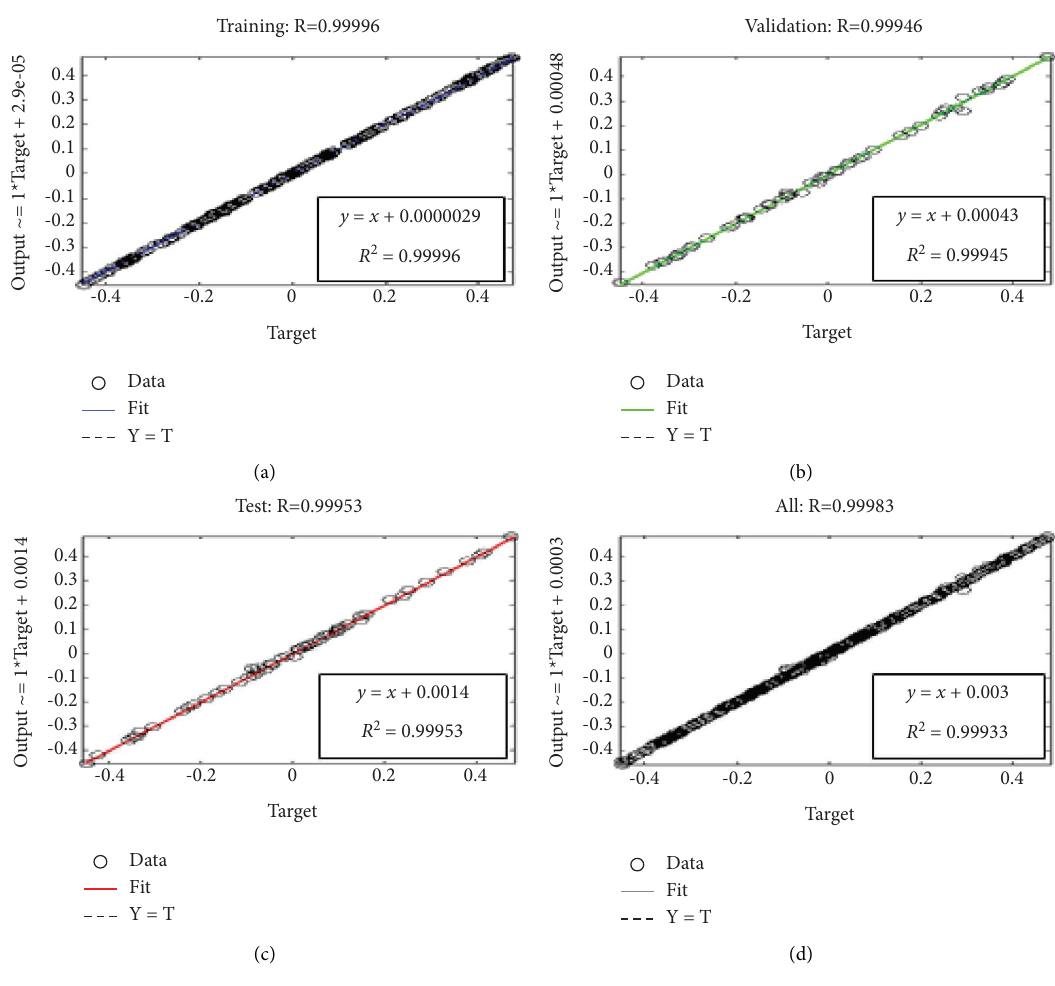
Figure 6: Regression plot for proposed wavelet—ANN. (a) Training: R � 0.99996. (b) Validation: R � 0.99946. (c) Test: R � 0.99953. (d) All: R � 0.99983.